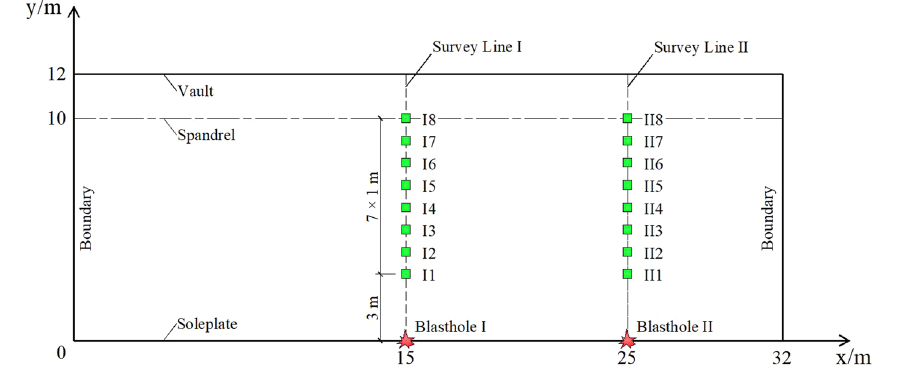
Figure 2. Sidewall blasting vibration survey points.